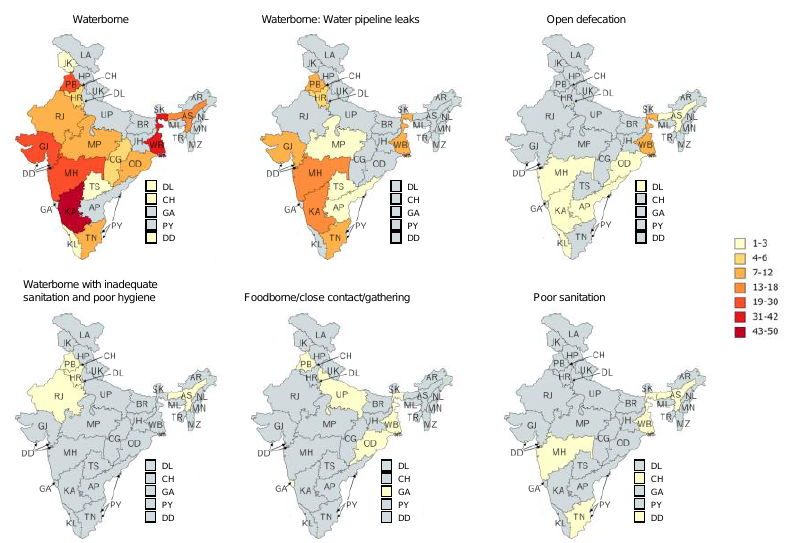
Figure 10. Number of cholera outbreaks ( n = 565) by state and transmission routes, India, 2011–2020. Multiple modes of transmission were involved in some outbreaks.